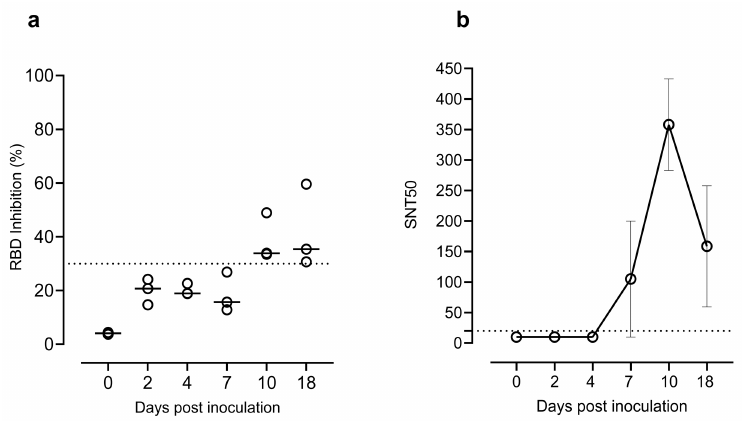
Figure 5. ( a ) Neutralising antibodies detected by the SARS-CoV-2 RBD Inhibition ELISA (Positive ≥ 30% RBD inhibition). ( b ) Neutralisation titres in sera samples from 0, 2, 4, 7, 10, and 18 dpi determined by the live virus neutralisation assay. Data reported as values of reciprocal dilution of SNT 50 (mean ± SEM). The horizontal dotted lines indicate the cut-off value of the assay. Abbreviations: RBD, receptor-binding domain; SNT 50 , serum virus neutralisation titre (reciprocal dilution) that showed 50% protection of virus growth .